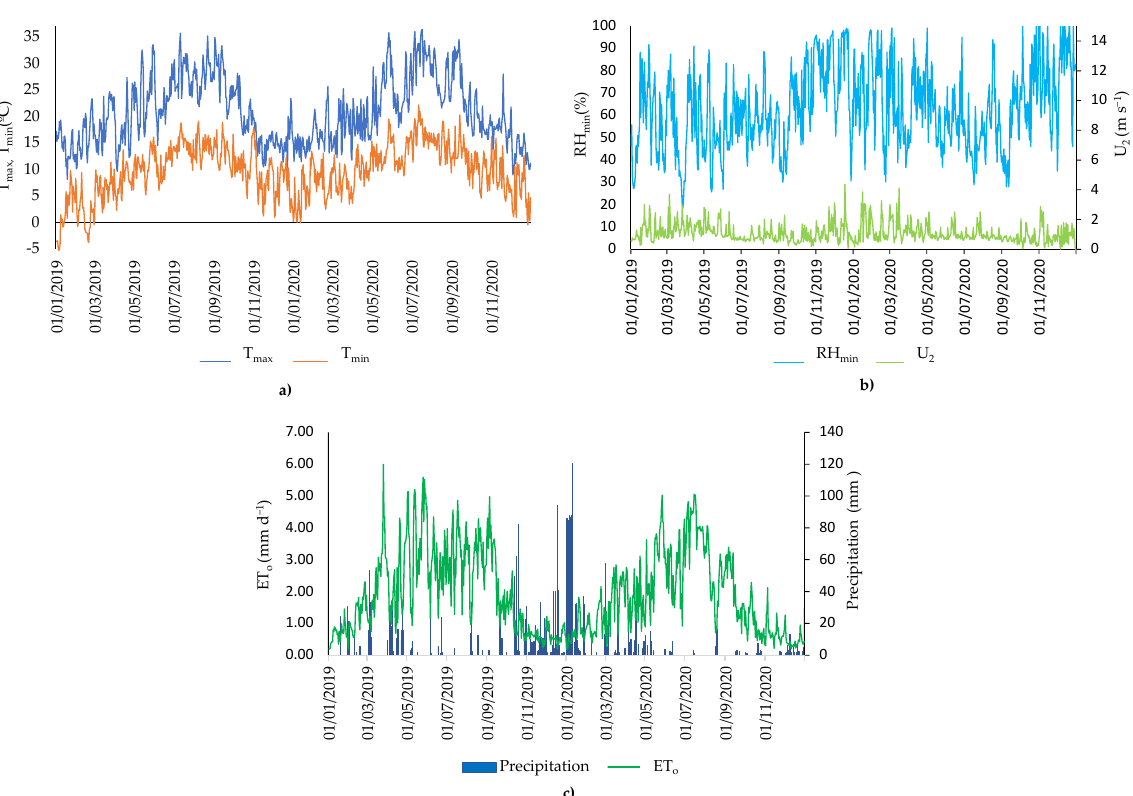
Figure 1. Daily weather data recorded in the field relative to ( a ) maximum (T max , °C) and minimum (T min , °C) temperatures; ( b ) minimum relative humidity (RH min , %), wind speed at 2 m height (U 2 , m s − 1 ) and ( c ) precipitation and reference evapotranspiration (ET o , mm d − 1 ) for the period 2019–2020.